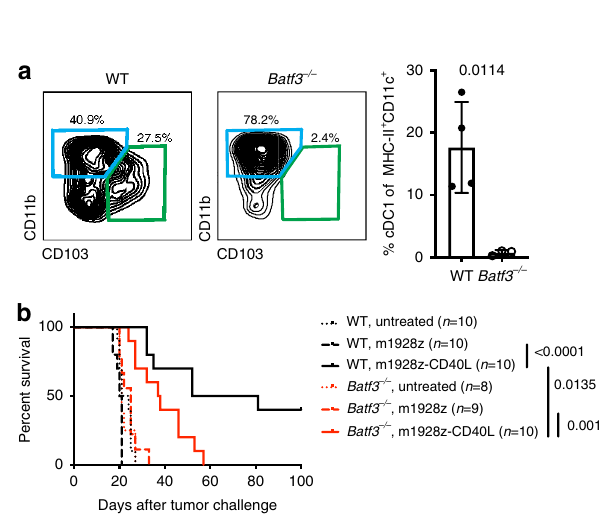
Fig. 2 Improved antitumor response of m1928z-CD40L CAR T cells requires presence of Batf3-expressing cDC1. a Flow cytometry contour plots of the MHC-II + CD11c + DC population in tumors of WT and Batf3 − / − mice on day 14 after A20.GL intravenous injection. Gates highlight